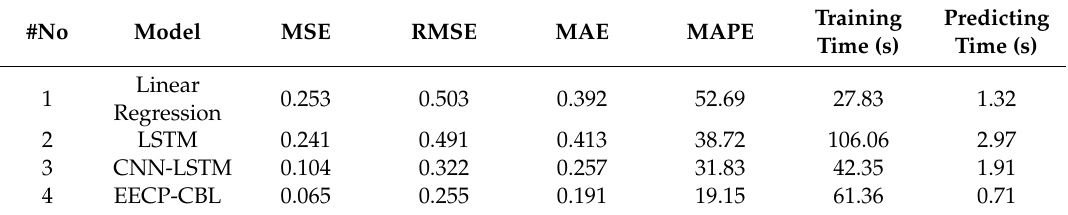
Table 5. Performances of the experimental methods for daily